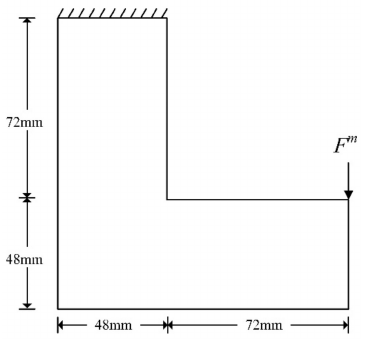
Figure 4. Design domain of L-shaped